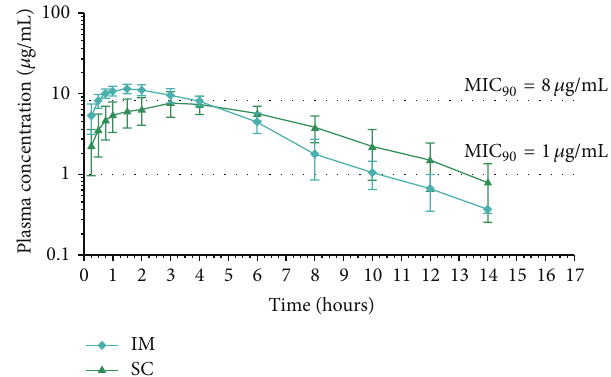
Figure2:Mean ± SDofplasmacephalexinconcentrationsfollowing sustained release formulation (8mg/kg) administration by the intramuscular (IM) and subcutaneous (SC) routes to 6 llamas.